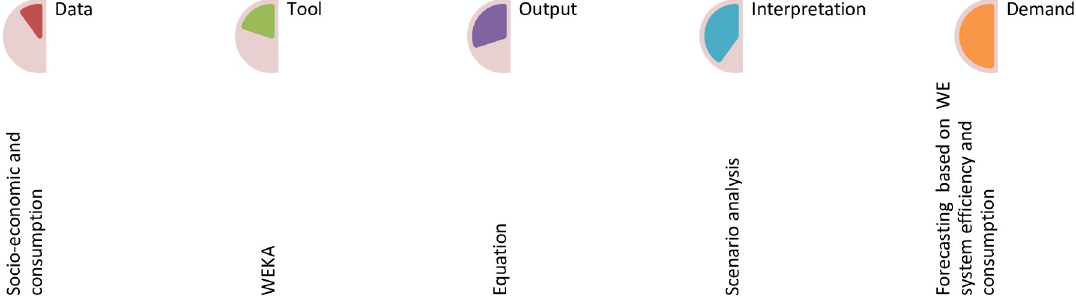
Fig 1. Flow diagram to predict the water-energy